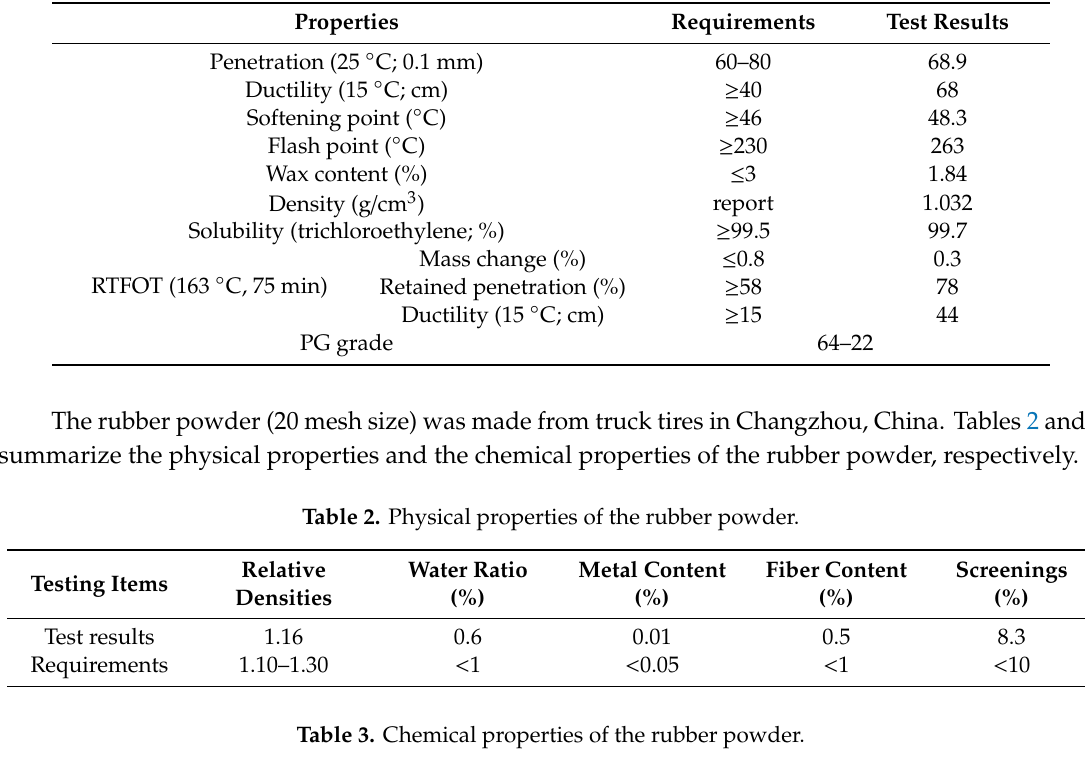
Table 1. Properties of the penetration grade 70 neat bitumen used in the present study.